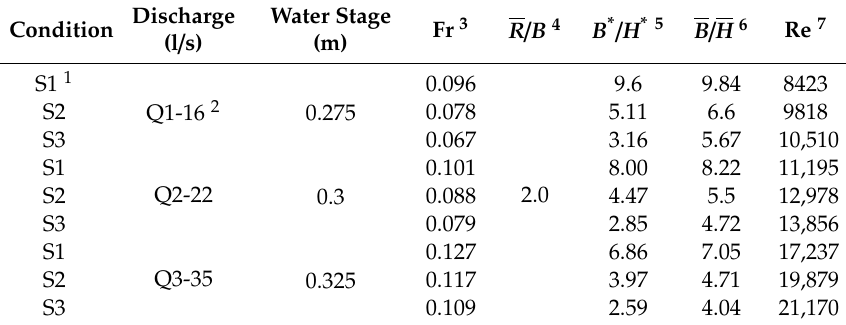
Table 1. Experimental conditions and measured